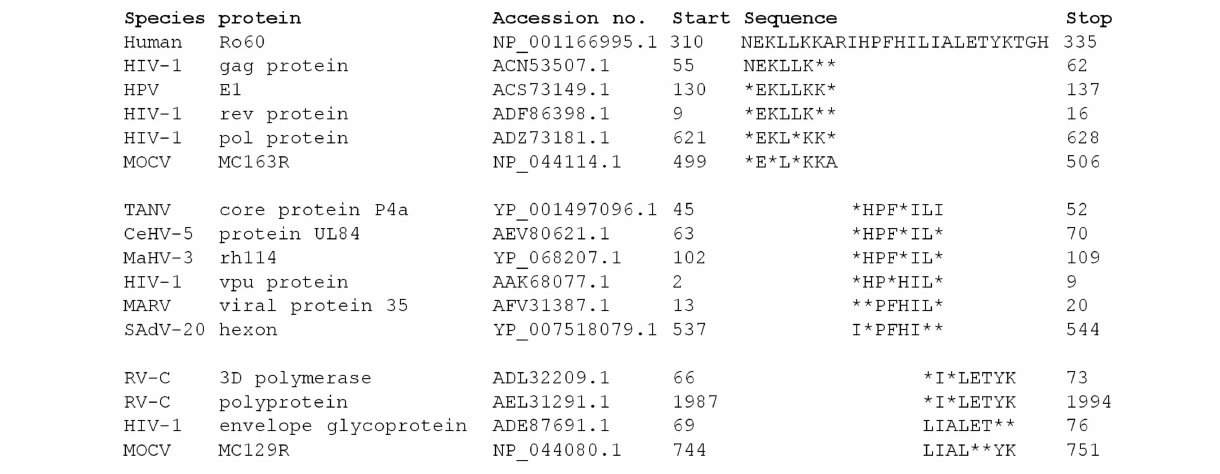
FigUre 5 | Analysis of the sequence homology between hRo60_310-335 and human virus proteins. Sequence homologies were analyzed by BLASTP software